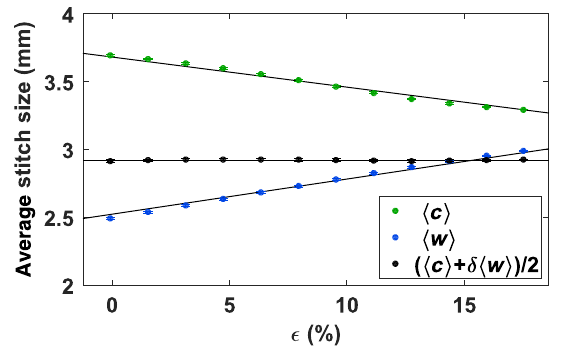
FIG. 5. The average stitch size as a function of the applied strain ε > 0 of the fabric used in Fig. 1. It is shown that h c i (resp. h w i ) follows a negative (resp. positive) linear trend; thus, we can define a parameter δ ¼ 0 . 86 such that h c i þ δ h w i is constant for all ε > 0 . Each data point is the average over 5 images at a given strain, and the error bars are twice their standard